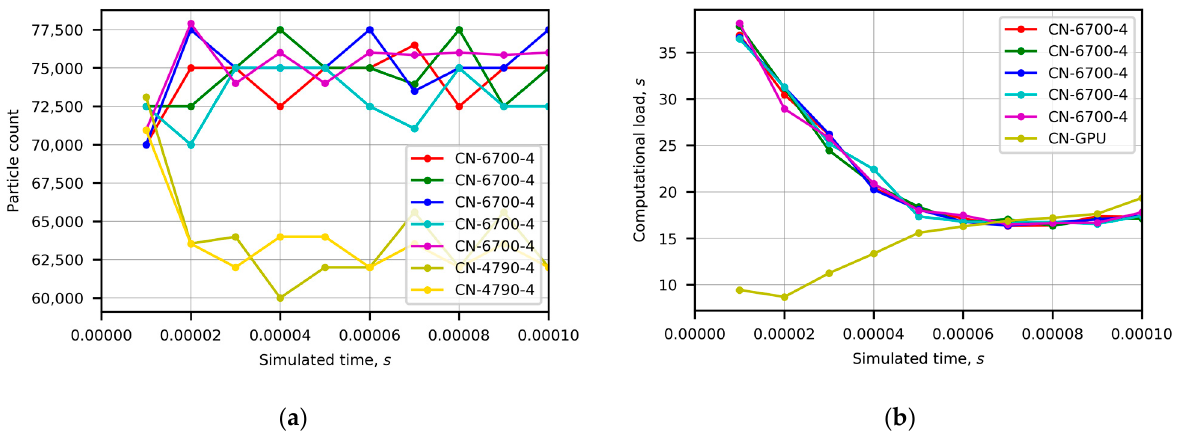
Figure 3. Time evolution of particle count in Case 2 ( a ) and computational load in Case 3 ( b ).